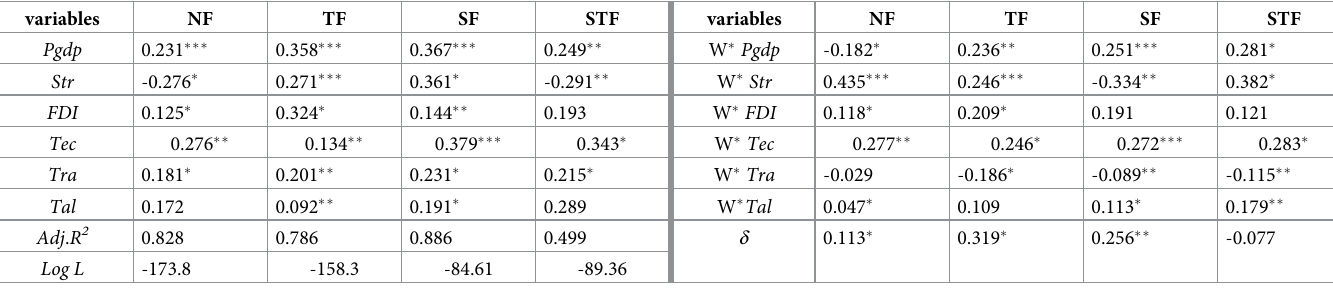
significance test of 0.05, indicating that there is a significant spatial spillover effect in the Table 6. SDM results for